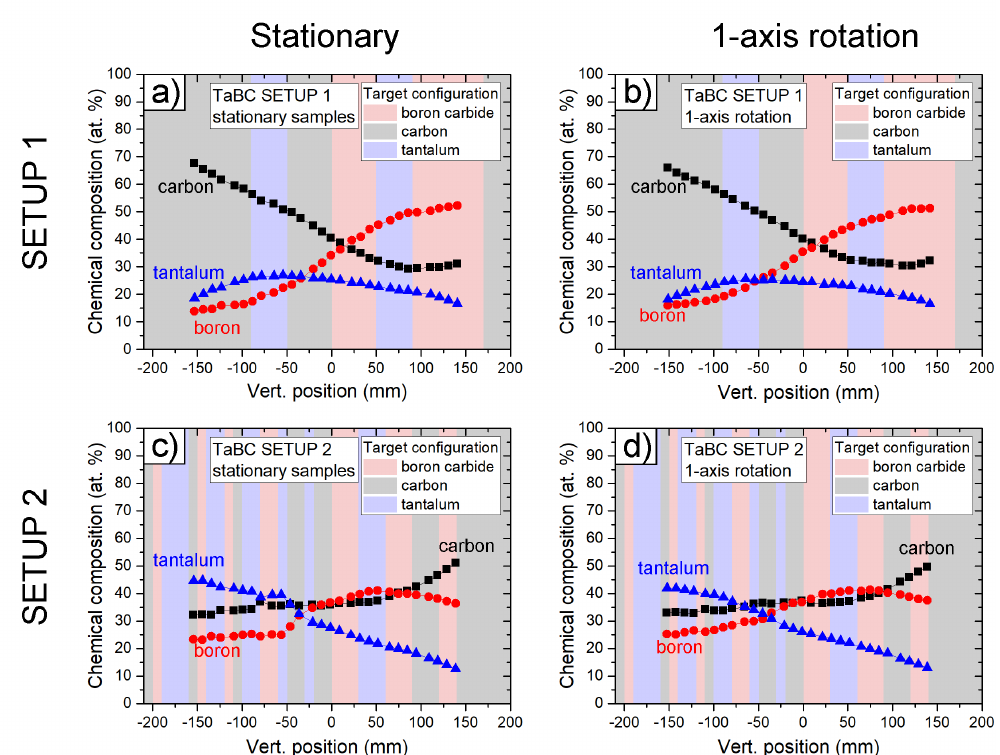
Figure 3. Chemical composition of the TaBC coatings with reference to the target setup and rotation during the deposition: ( a ) stationary placed samples and ( b ) samples carrying 1-axis rotation prepared with target in Setup 1; ( c ) stationary placed samples and ( d ) samples carrying 1-axis rotation prepared with target in Setup 2.